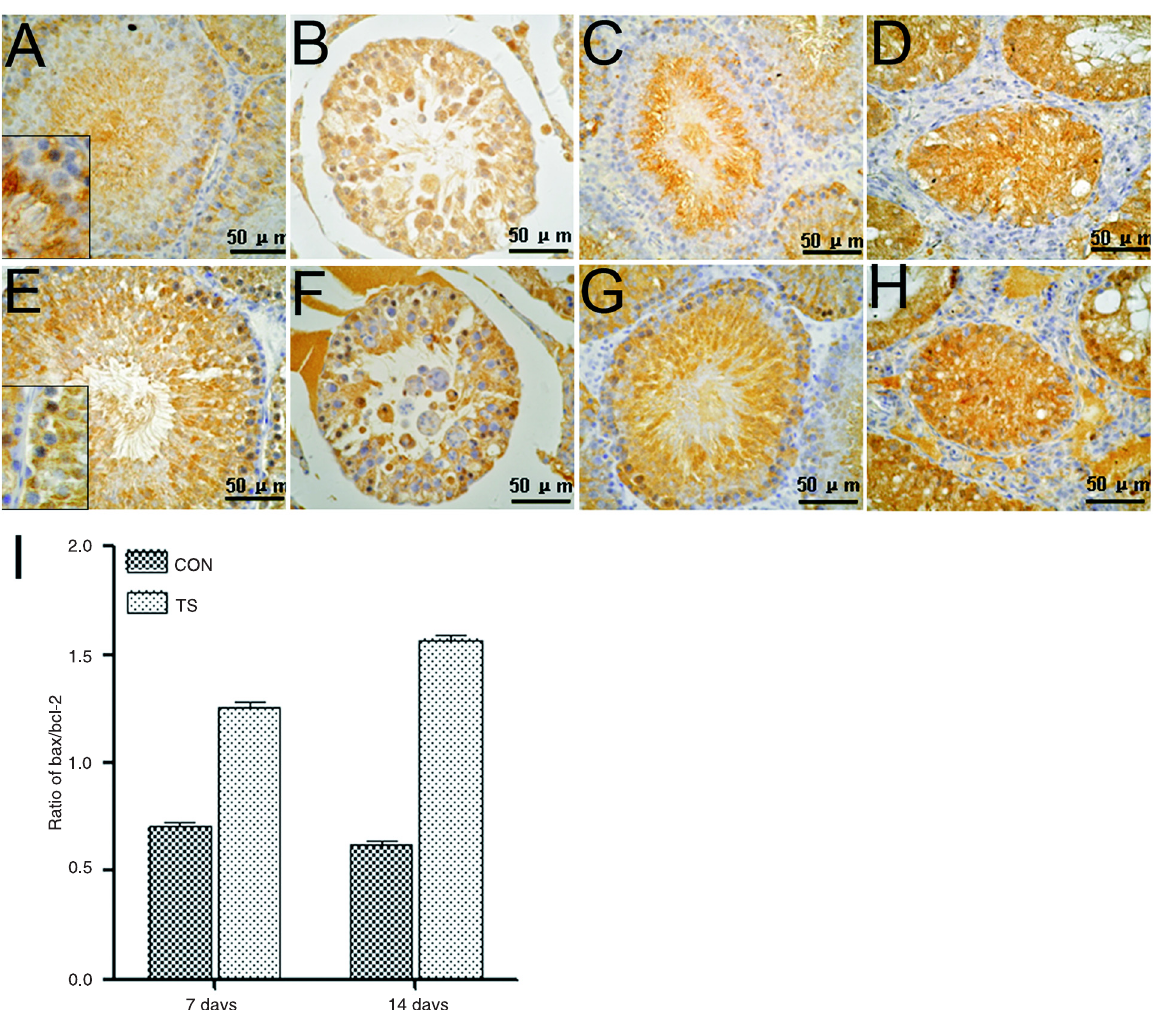
Figure 5. Detection of apoptosis by anti-bax and anti-bcl-2 immunoassay. In situ immunoassay for bax: A , control (CON) group for 7 days; B , tail-suspended (TS) group for 7 days; C , control group for 14 days; D , TS group for 14 days. In situ immunoassay for bcl-2: E , control group for 7 days; F , TS group for 7 days; G , control group for 14 days; H , TS group for 14 days. I , The bax/bcl-2 ratio is obtained by dividing the intensity of bax-positive substance by that of bcl-2-positive